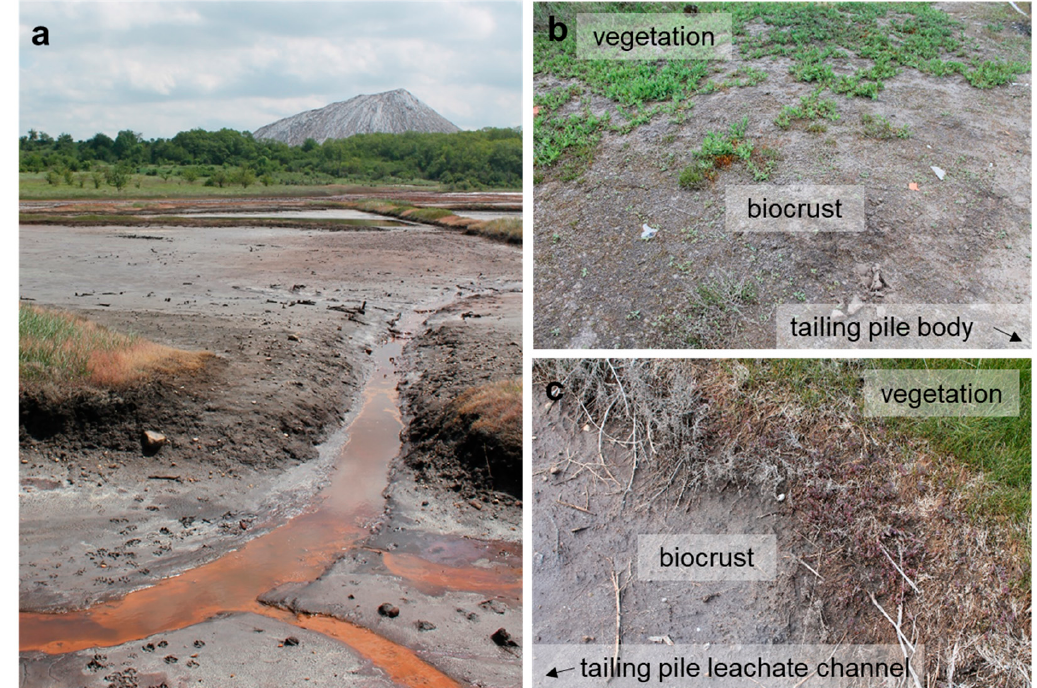
Figure 1. The potash tailing pile in Teutschenthal, Germany. ( a ) The plain in front of the tailing pile represents an abandoned lignite mine, which is regularly flooded by highly saline tailing pile leachate. ( b ) Biocrusts close to the Teutschenthal tailing pile between the vegetation and tailing pile body and ( c ) between the vegetation and tailing pile leachate water channels.